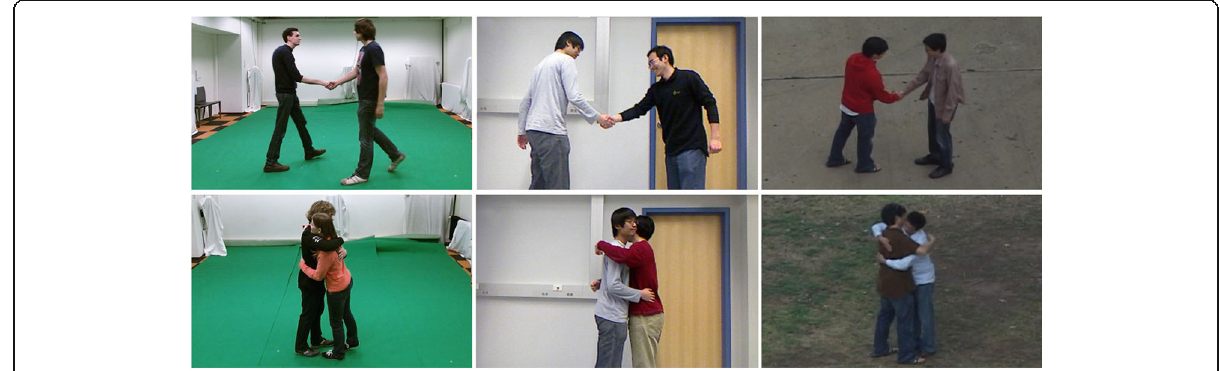
Fig. 6 Example frames from ShakeFive2, SBU Kinect, and UT-Interaction. Top row: handshake, bottom row: